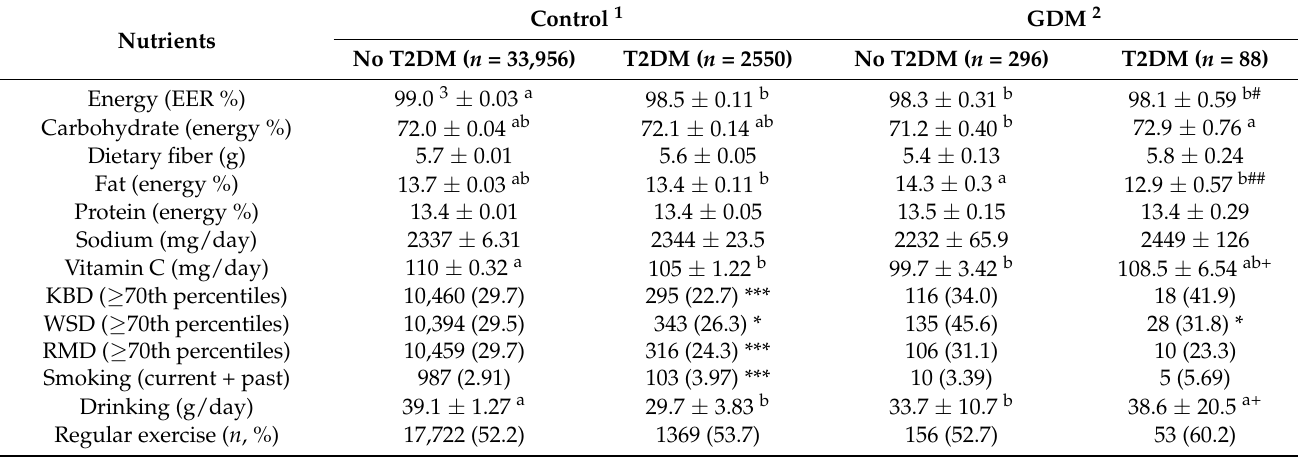
Table 2. Nutrient intake of patients with gestational diabetes (GDM) diagnosis according to type 2 diabetes (T2DM).